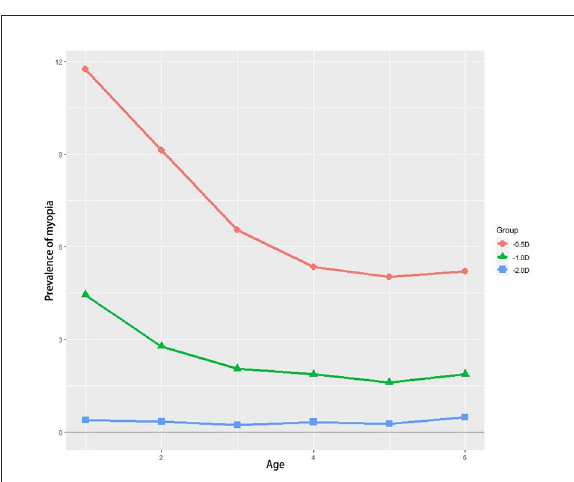
FIGURE2 The prevalence of myopia that is defined by three thresholds among the six different age groups. D, diopter.